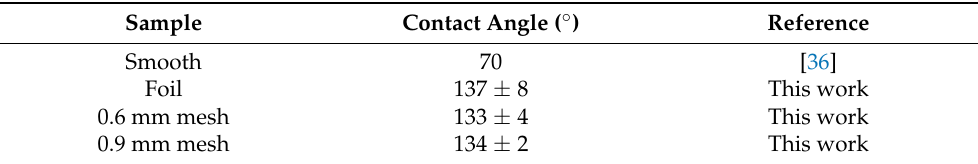
Table 1. Water contact angle of selected patterned fiber samples compared to samples collected on foil as a measure of water repellent